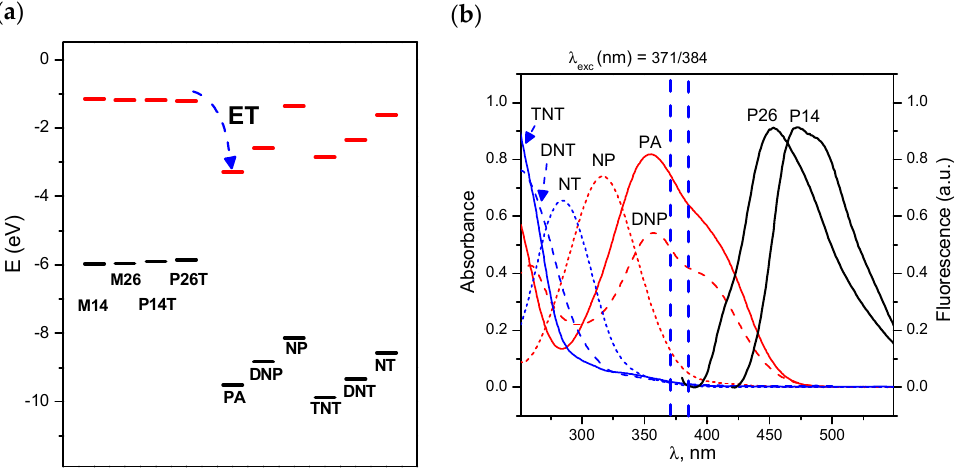
Figure 5. ( a ) Frontier molecular orbitals energies (DFT/PBEh-3c) of M14 , M26 and tetramers ( P14T and P26T ) of P14 and P26 . Values for the frontier molecular orbitals (FMOs) of the quenchers are also included. ( b ) UV-Vis absorption spectra, [NAC] = 56 mM. Fluorescence spectra of P14 and P26 are also included. Vertical dashed lines indicate the excitation wavelengths used to record fluorescence